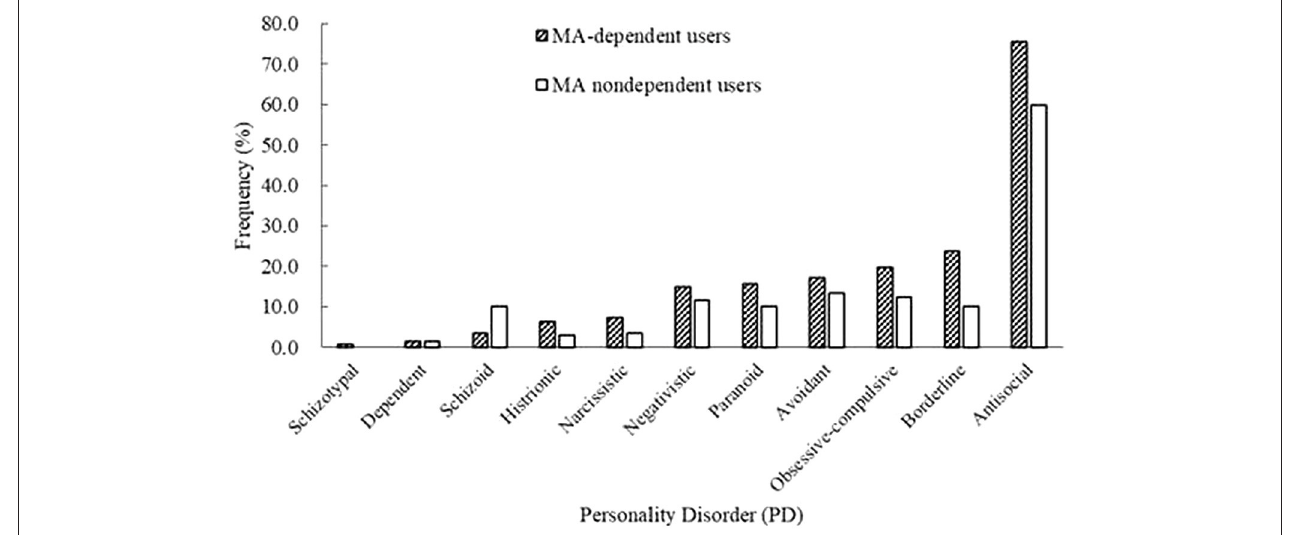
FIGURE 1 | Prevalence rates of personality disorders (PDs) between methamphetamine (MA)-dependent users and non-dependent users.